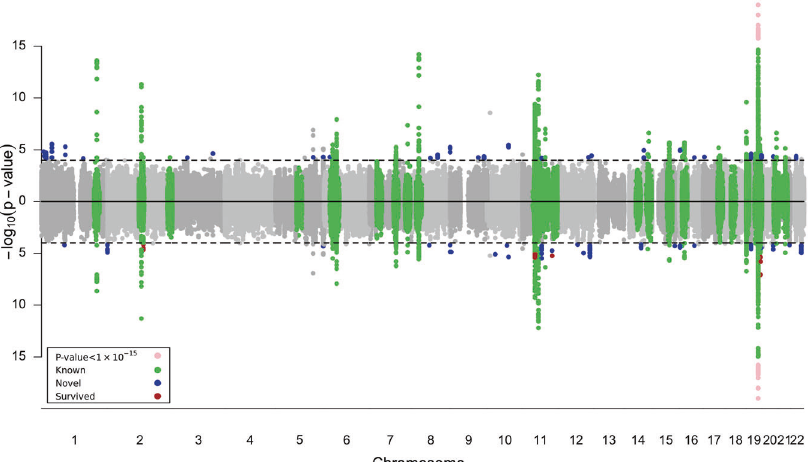
Fig. 1 Miami plot of tissue-speci fi c GReX association tests with LOAD from meta-analysis of AGDC and IGAP (top) or ADGC-only (bottom). The green region labels the ±10 Mb of known AD loci, the blue dot indicates the novel gene, which locates outside the known AD region (green) and is never reported in previous GWAS, and the brown dot in ADGC-only meta-analysis suggests the gene holds signi fi cance in conditional analysis. P -values less than 1 × 10 − 15 were truncated (pink dot) to improve the clarity of peaks in other, less signi fi cant